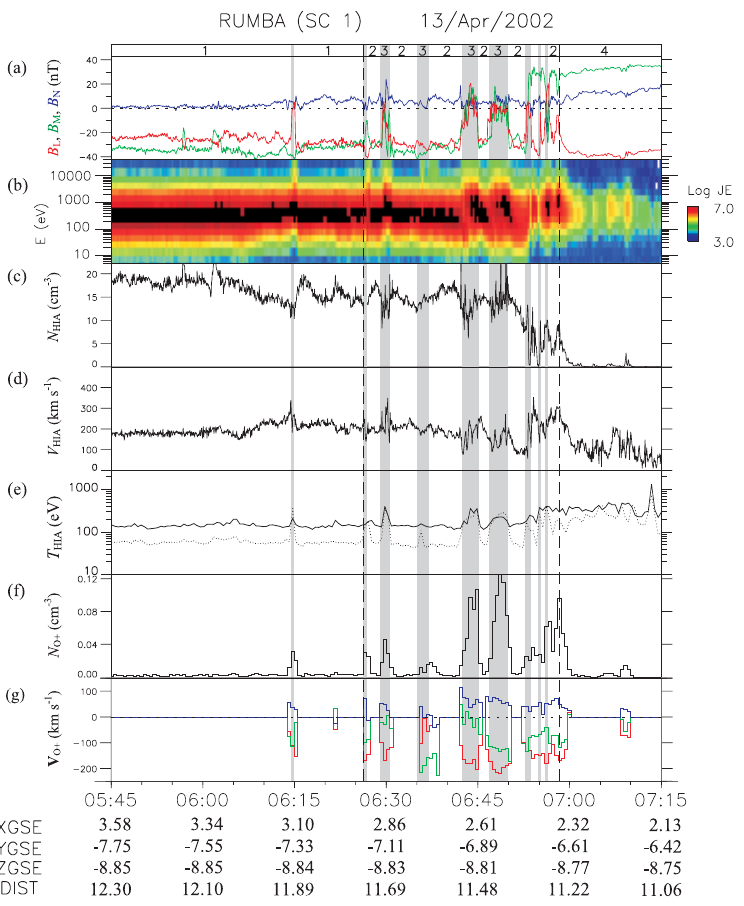
Fig. 3. Measurements in the magnetosheath/MP/magnetosphere from Cluster SC1 on 13 April 2002. ( a ) Magnetic field components in the LMN frame, ( b ) ion energy-time spectrogram in Log [eV/(scm 2 sreV)] from HIA, ( c ) ion number density in cm − 3 from HIA, ( d ) ion flow speed in km s − 1 from HIA, ( e ) parallel (dot) and perpendicular (solid) ion temperatures from HIA, ( f ) O + number density in cm − 3 , ( g ) O + velocity components in the LMN coordinate system in kms − 1 . L, M, and N components are plotted in red, green and blue, respectively. A region identifier bar at the top sorts intervals of Eq. (1) magnetosheath proper, Eq. (2) magnetosheath transition layers, Eq. (3) magnetospheric transition layers (also in gray), and (4)